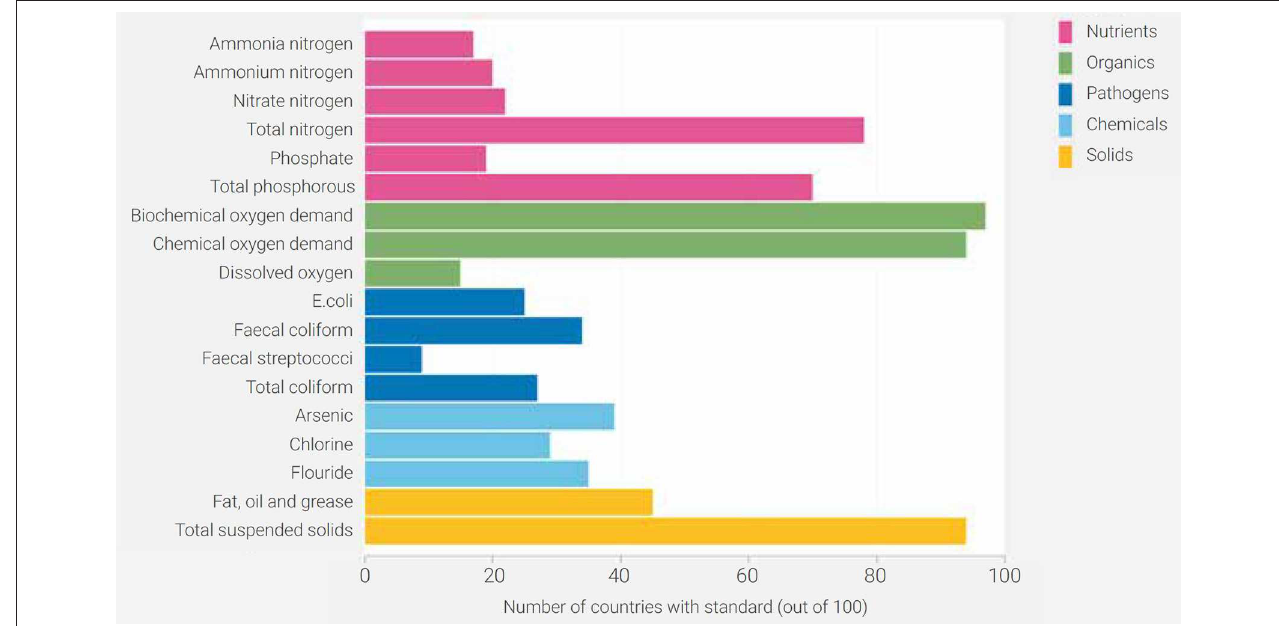
FIGURE 1 | National discharge standards of 100 countries (WHO,